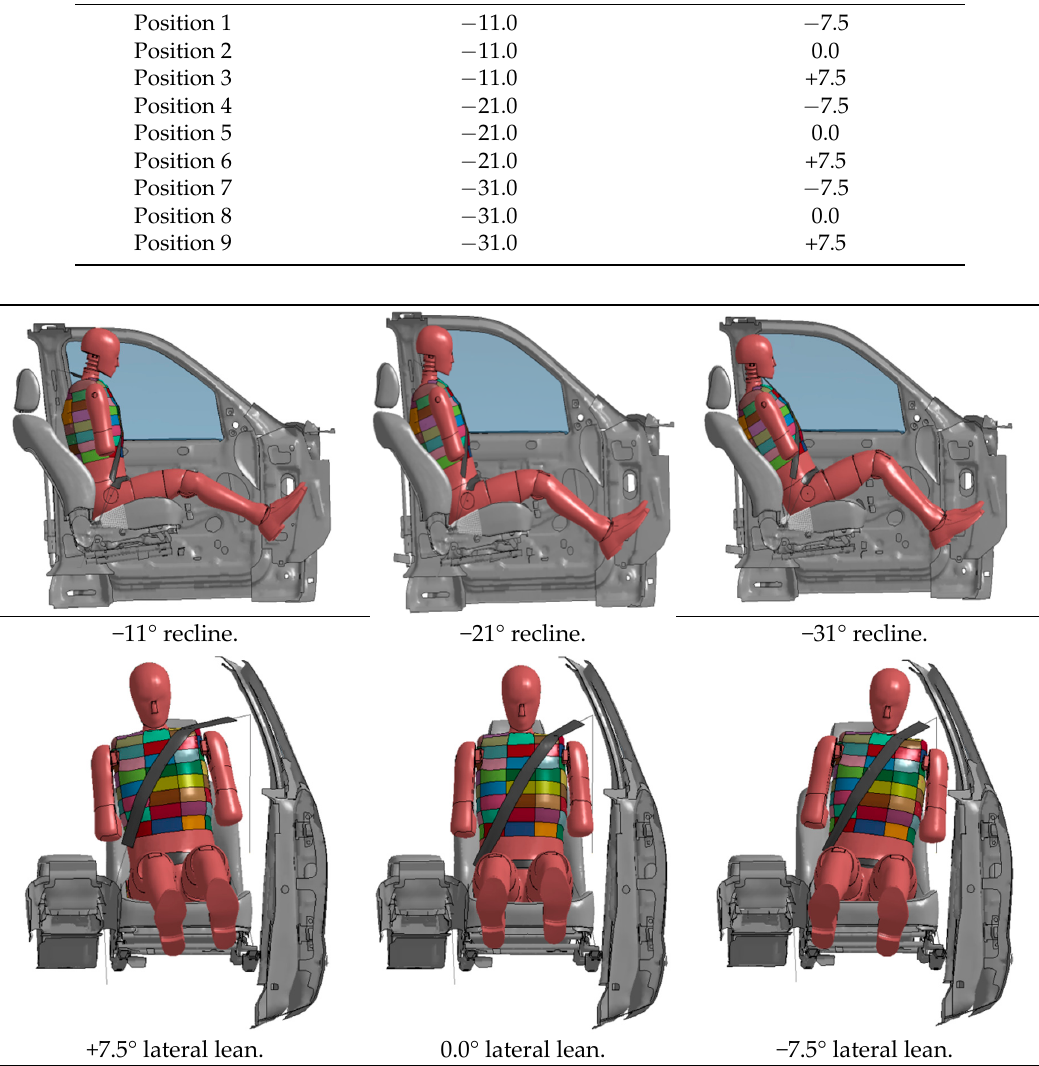
Figure 2. Anthropomorphic test device (ATD) anterior–posterior recline angles relative to the vertical axis ( top ) and ATD lateral lean angles relative to the vertical axis ( bottom ).